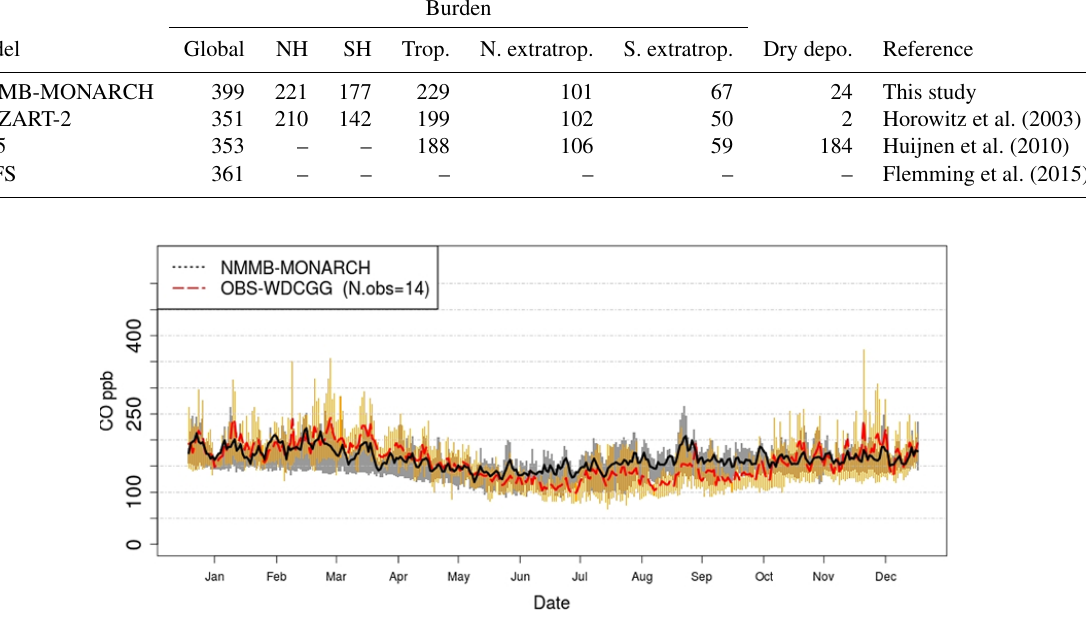
Figure 3. Time series of CO daily mean concentration in ppb averaged over all the rural WDCGG stations used. Observations are depicted with a solid red line and model data with a solid black line. Bars show the 25th–75th quartile interval for observations (orange bars) and the model (gray